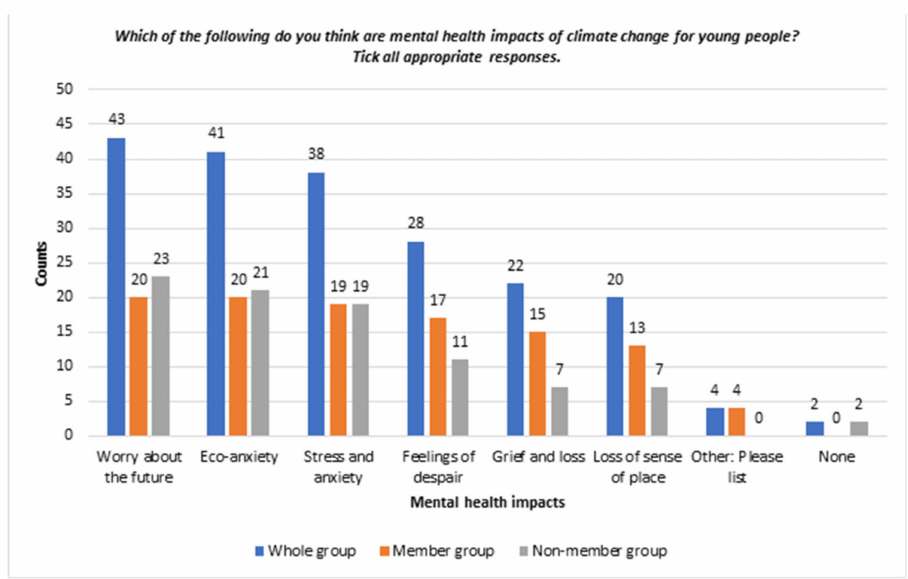
Figure 1. Bar chart of young people’s perceptions on negative mental health impacts of climate change—whole sample and between